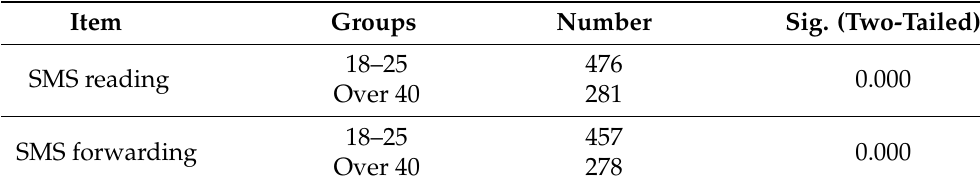
Table 8. Forwarding and reading of short messages between